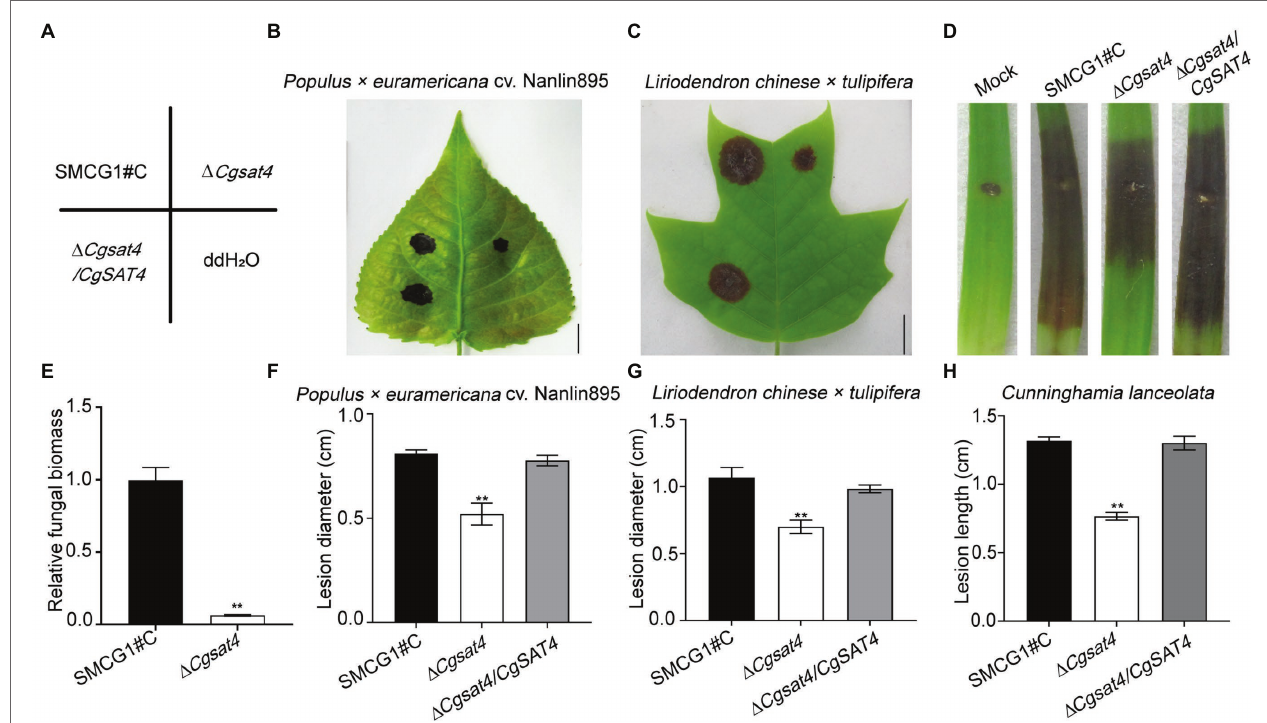
FIGURE 5 | CgSat4 required for full virulence in C. gloeosporioides . (A) Diagram of inoculation sites of the WT, ∆ Cgsat4 mutant and complemented strain on the unwounded leaves of Populus × euramericana cv. Nanlin895 and Lirioden dronchinensis × tulipifera . n = 3. (B,C) Pathogenicity assays on leaves of Populus × euramericana cv. Nanlin895 and L. dronchinensis × tulipifera for 5 days indicated in (A) , respectively. n = 3. (D) Pathogenicity assays on wounded leaves of C. lanceolata for 5 days. n = 3. (E) Relative fungal biomass of the WT and ∆ Cgsat4 mutant monitored from infected tissues of L. dronchinensis × tulipifera at 3 dpi, respectively. n = 3. (F–H) Lesion diameter of lesions on the inoculated leaves showed in (B–D) , respectively. n = 3. Error bars represent the SD. Asterisks indicates significant difference at p <